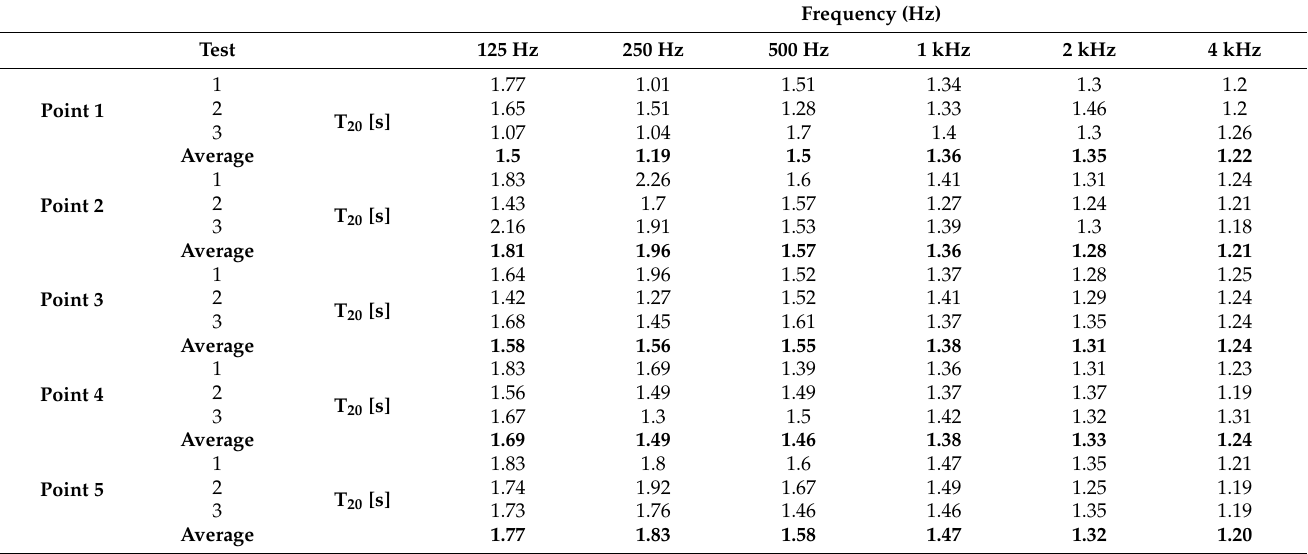
Table 11. On-site measurements: T 20 of Combo 02.